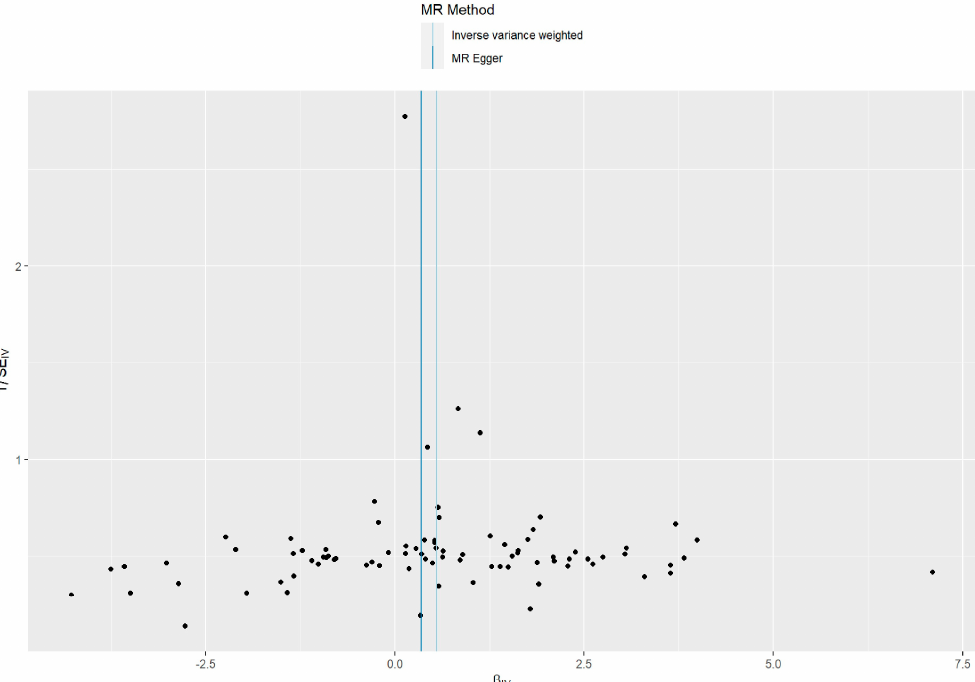
Figure 3. A funnel plot of the relationship between the causal effect of PM2.5 on GDM. Funnel plots showed the relationship between the causal effect of PM2.5 on GDM estimated with each SNP as a separate instrument and the inverse of the standard error of the causal estimate. Each black point represents a valid instrumental SNP. The vertical line represents the estimated causal effect of all instrumental SNPs using the two different methods.